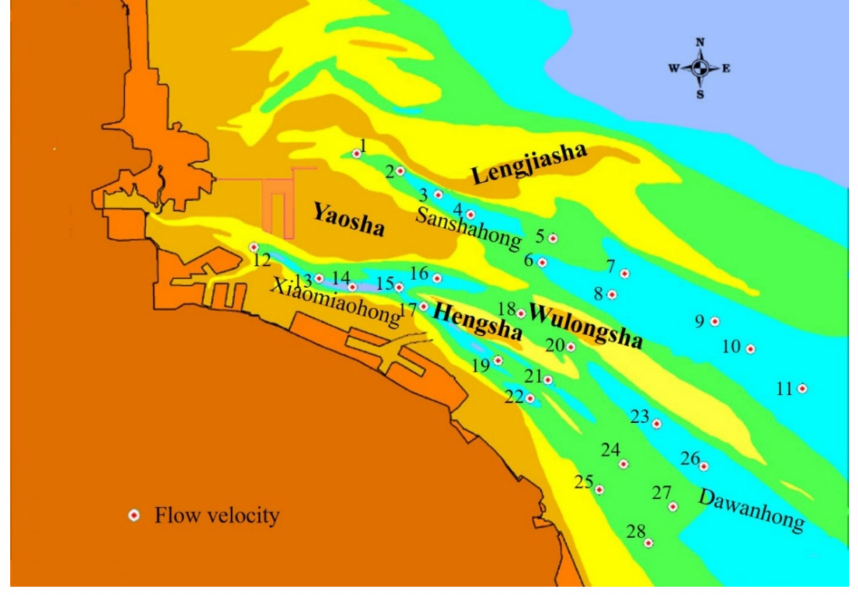
Figure 6. Location map of velocity in water channel.